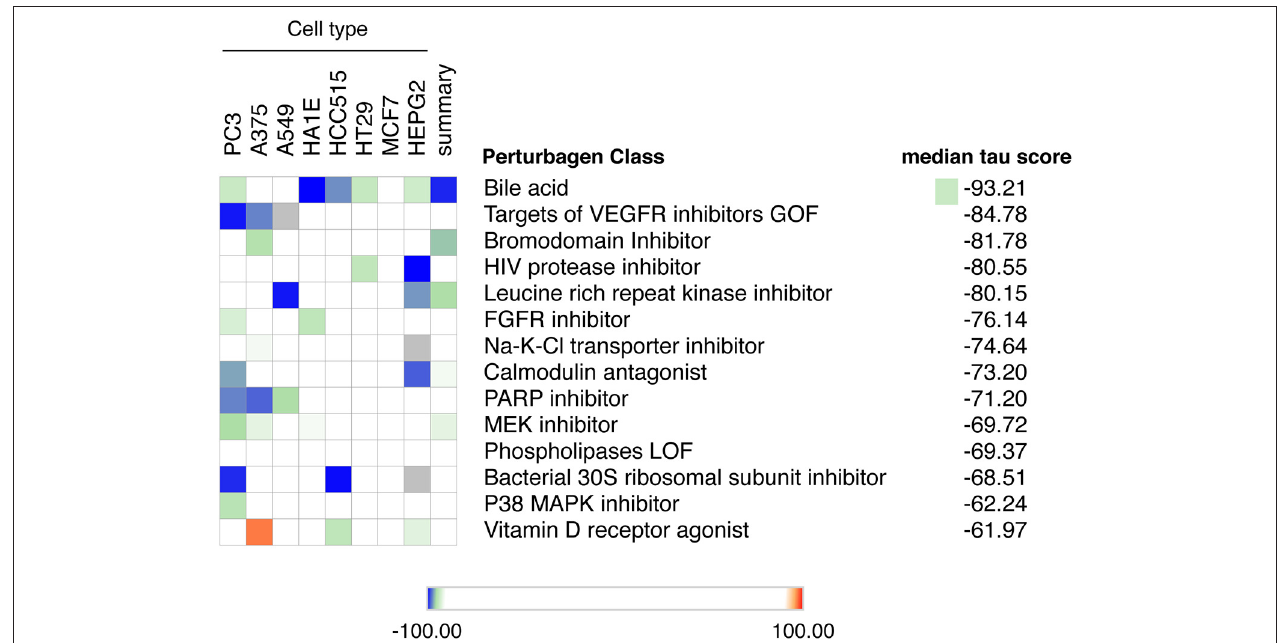
FIGURE 5 | Mining the beta cell signature in T1D to identify potential new therapeutic targets. The top 150 up-regulated transcripts identified in the RNA-seq of beta cells of T1D individuals ( 14) were used to query the Connectivity Map database of cellular signatures (7). The top Connectivity Map classes of perturbagens that promote an opposite signature (negative tau scores) to the one present in beta cells of T1D individuals are